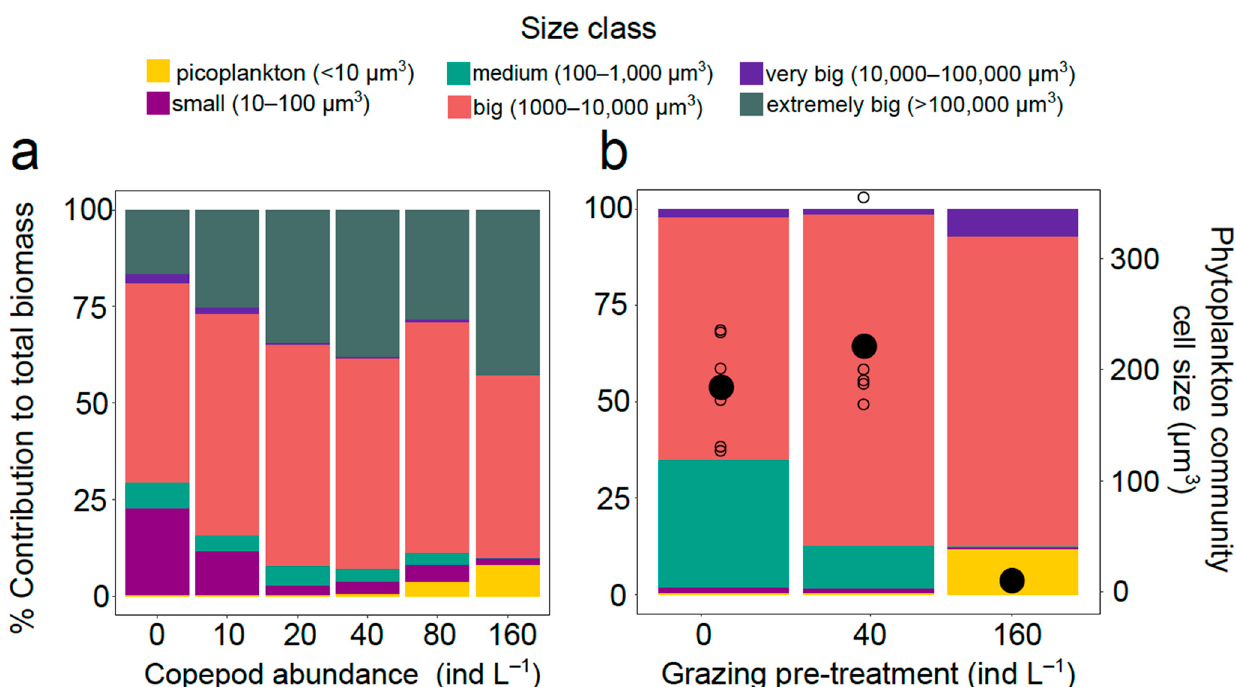
Figure 1. % Contribution to total biomass of size classes (picoplankton, small, medium, big, very big, extremely big) ( a ) in differently pregrazed treatments after seven days of grazing, ( b ) in selected pregrazed treatments after sieving for copepods. Panel ( b ) shows, also, mean community cell size ( µ m 3 ) (secondary axis) in grazing pretreatments (0, 40 and 160 ind L –1 ) after sieving for copepods. Empty circles indicate mean community cell size of replicates and black circles indicate mean cell size of each pregrazed treatment.